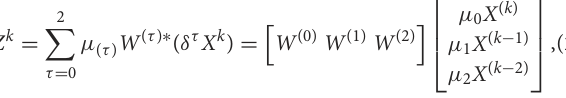
Algorithm 16. MP algorithm (Rutkowski et al.,